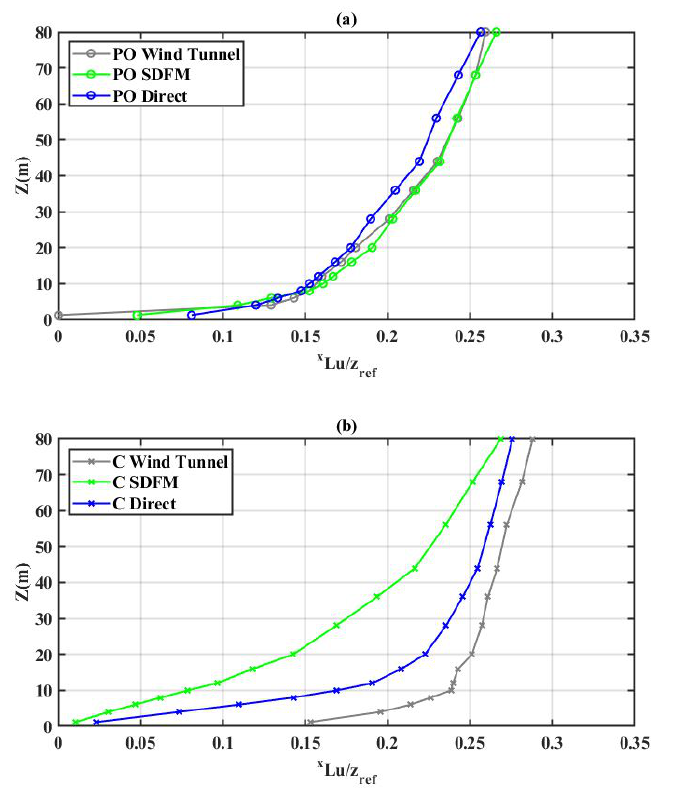
Figure 7. Integral length scale at ( a ) PO and ( b ) C as extracted from experiments and calculated by SDFM and direct